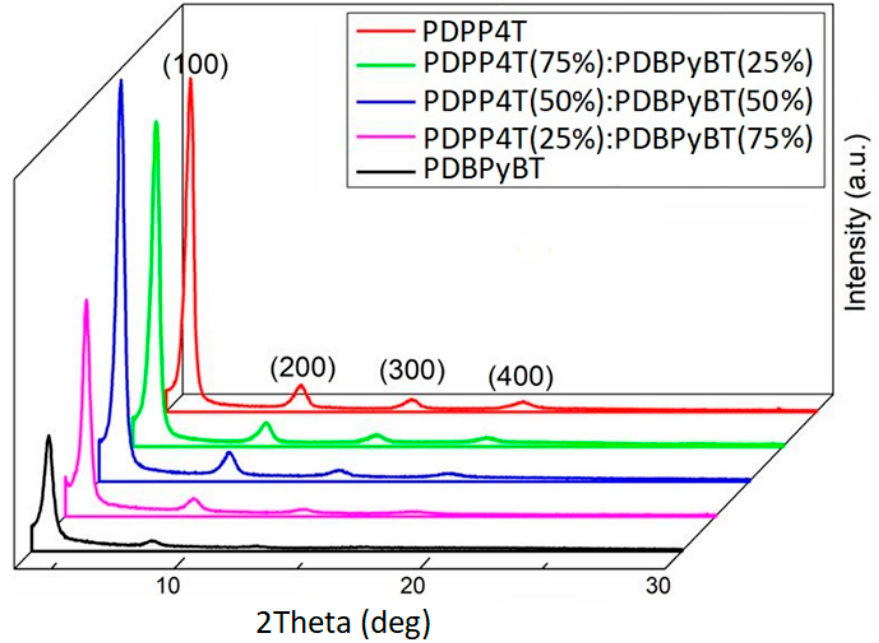
Figure 2. XRD scans, in coupled two-theta/theta mode, of PDPP4T, PDBPyBT and their blends.